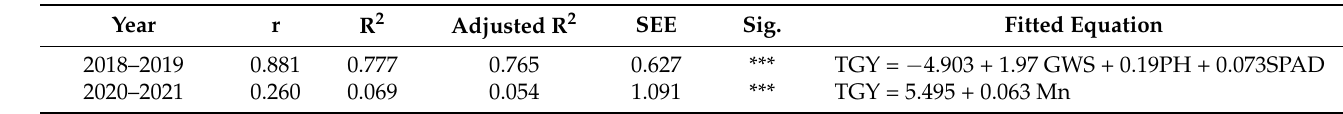
Table 11. Proportional contribution in predicting total grain yield (TGY) using stepwise multiple linear regression for some wheat varieties plants applied with different humic substances levels